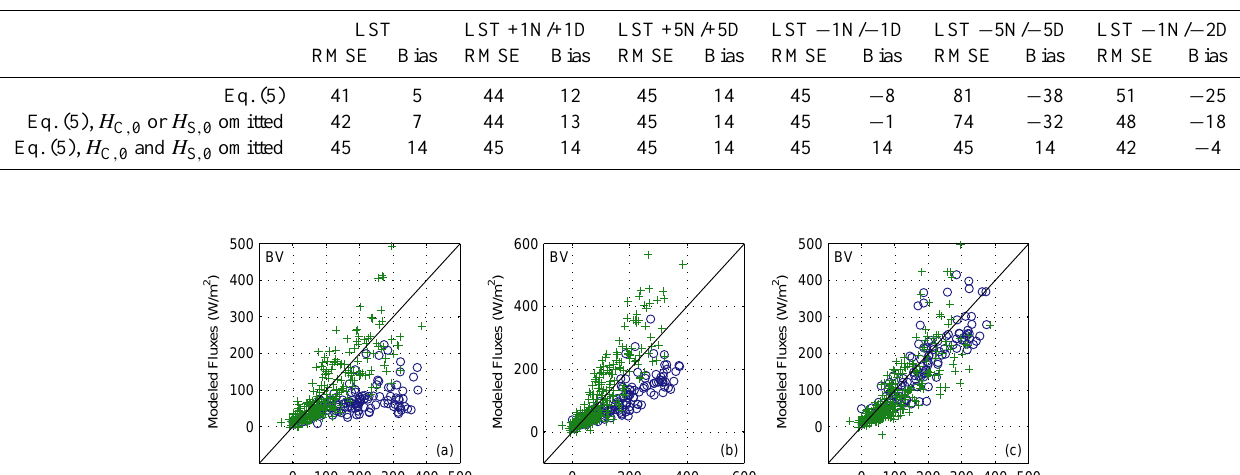
Table 4. RMSE and bias (modelled − observed) of instantaneous modelled energy fluxes (W m − 2 ) for different model configurations. Driven by field data from Voulund, with and without bias introduced to both day (D) and night (N) LST measurements.